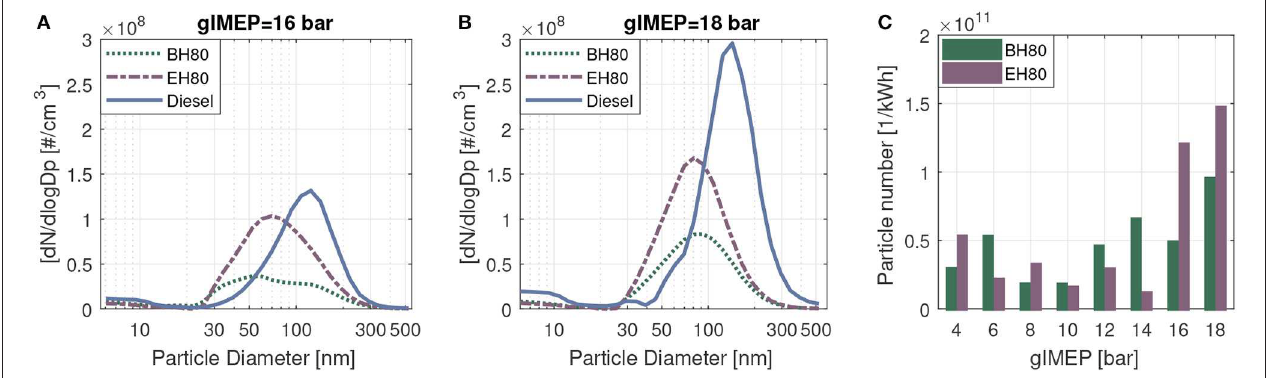
FIGURE 11 | Particle size concentration distribution (A) gIMEP = 16 bar, (B) gIMEP = 18 bar, and total particle number (C)